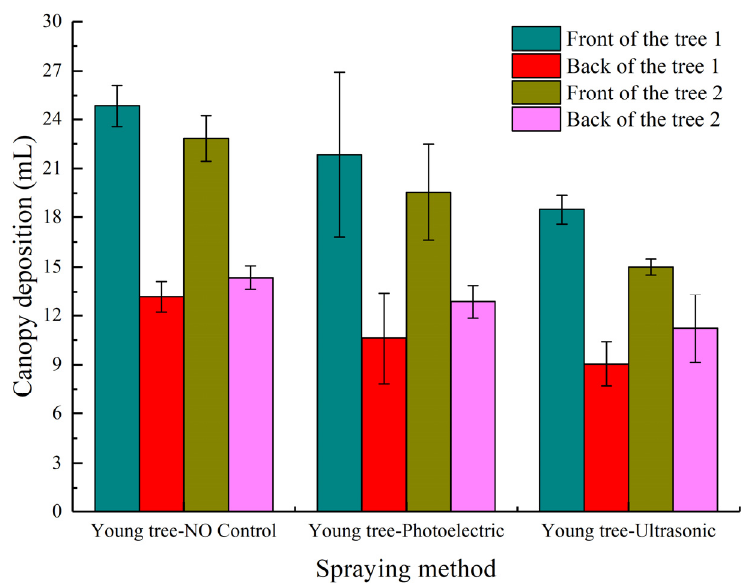
Figure 14. Canopy deposition distribution among the young cherry trees.